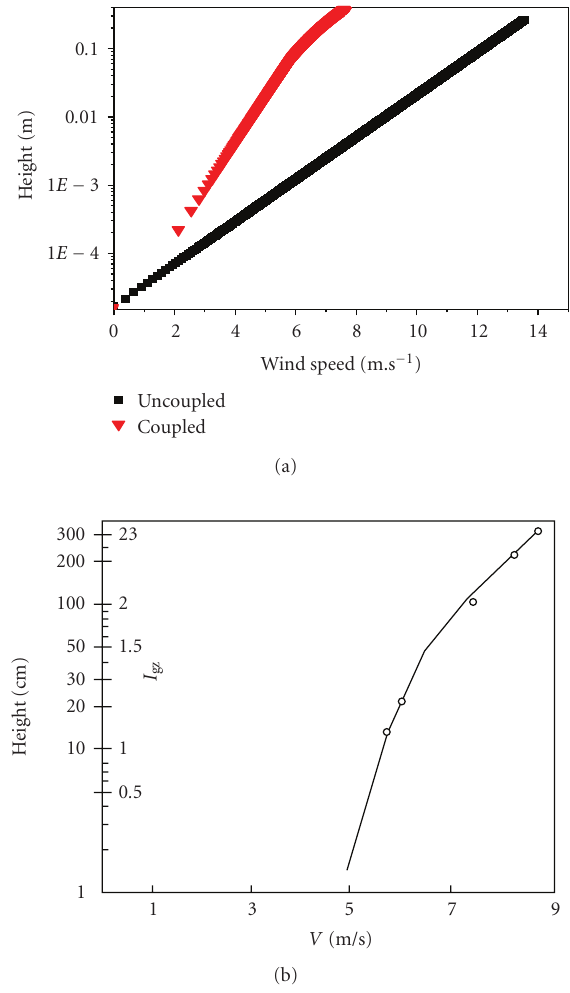
Figure 5: (a) A comparison of the coupled and uncoupled wind velocity profiles. (b) The experimentally determined wind profile of Zhonglong